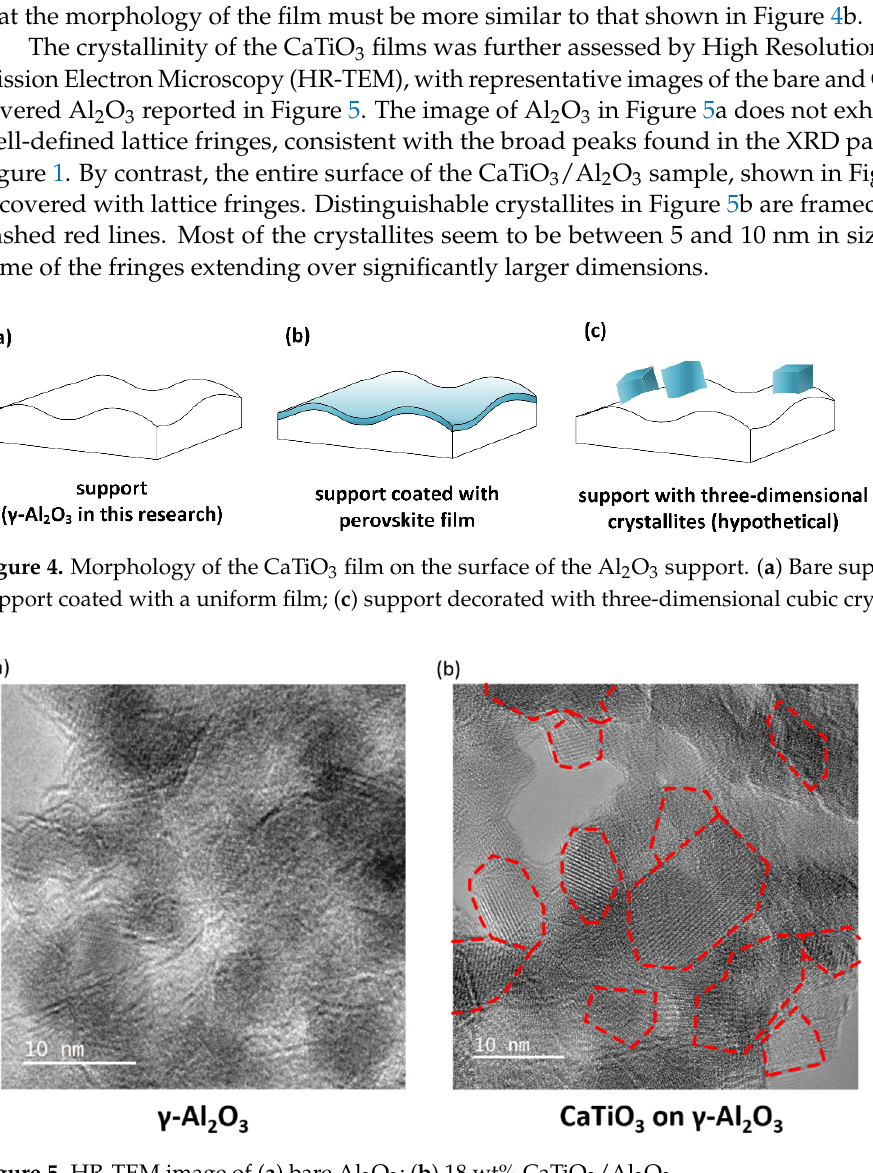
Figure 6. HR-TEM image of the 18 wt% CaTiO 3 /Al 2 O 3 sample . The question arises whether the Al 2 O 3 support plays a role in crystallizing the perovskite film. To address this issue, we also deposited a 0.5 nm film (0.37 g/g SiO 2 ) of a mixed oxide with the CaTiO 3 stoichiometry (The Ca:Ti ratio of the sample was 0.93:1 based on the ICP-OES results) onto an amorphous silica that had a sur- face area of 180 m 2 /g. Growth rates of CaO and TiO 2 on SiO 2 are presented in Figure S4. The sample was again oxidized at 1073 K for 3 h. As shown in Figure S2, the film was largely amorphous, except for a few minor peaks corresponding to an